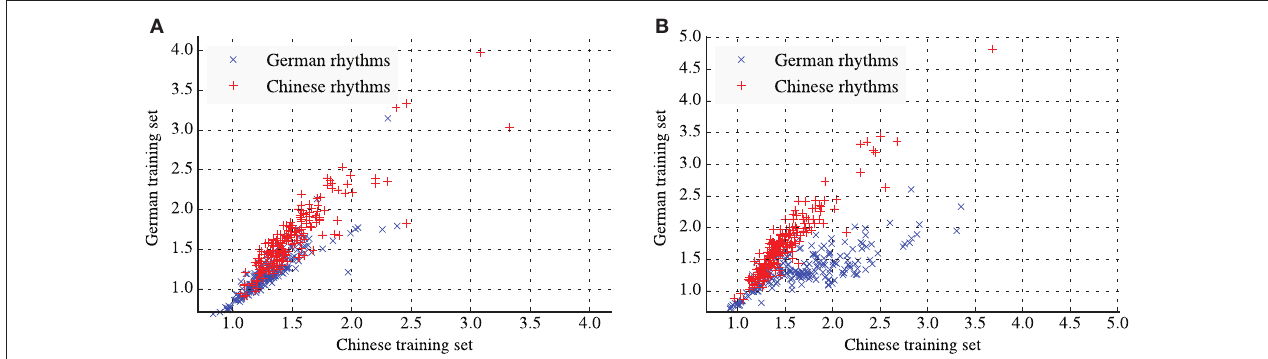
FIGURE 4 | Scatter plots of the average information content of rhythms for the Chinese and German models. (A) Results for the training and test sets with fixed distributions of meters. (B) Results for the training and test sets with empirical distributions of meters.